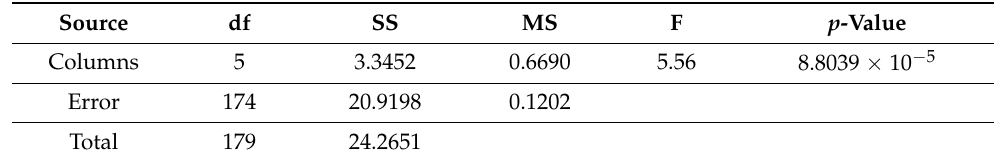
Table 8. ANOVA results for first shadow scenario.